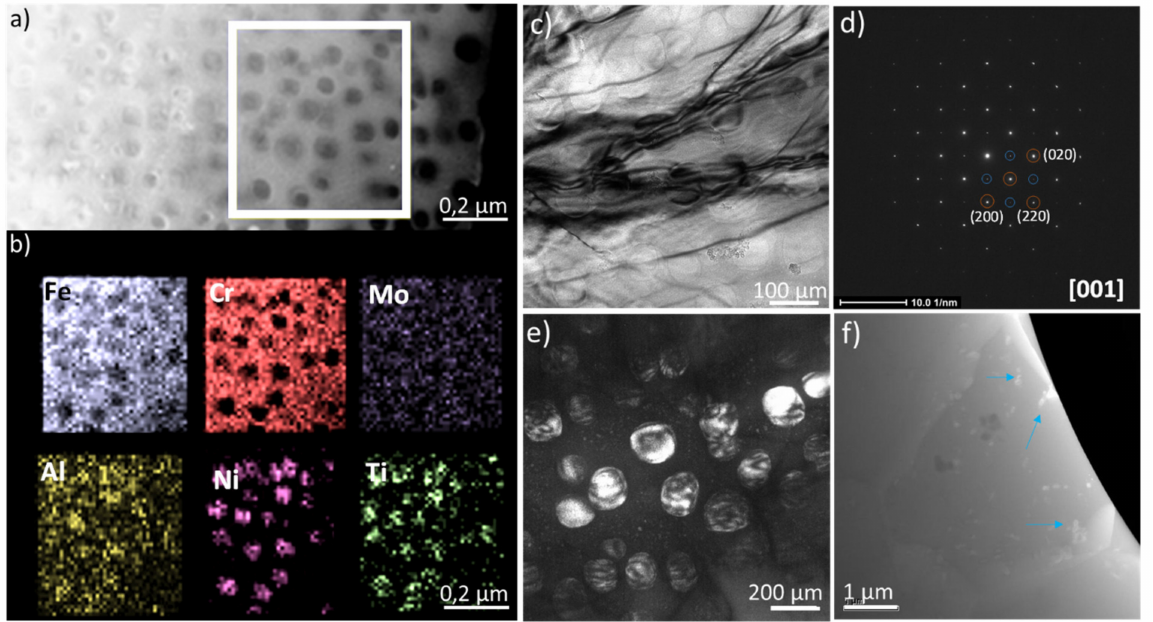
Figure 5. ( a ) A6 TEM image and ( b ) TEM-EDS elemental mapping of A6 sintered at 200 K/min, obtained from the area enclosed by the white square in 5a; ( c ) A6 BF image and ( d ) A6 TEM diffraction pattern obtained in the [001] zone axis corresponding to both the BCC matrix and the B2 coherent precipitates. The blue spots correspond to the ordered B2 coherent precipitates, ( e ) A6 BF image, and ( f ) A5 TEM image.